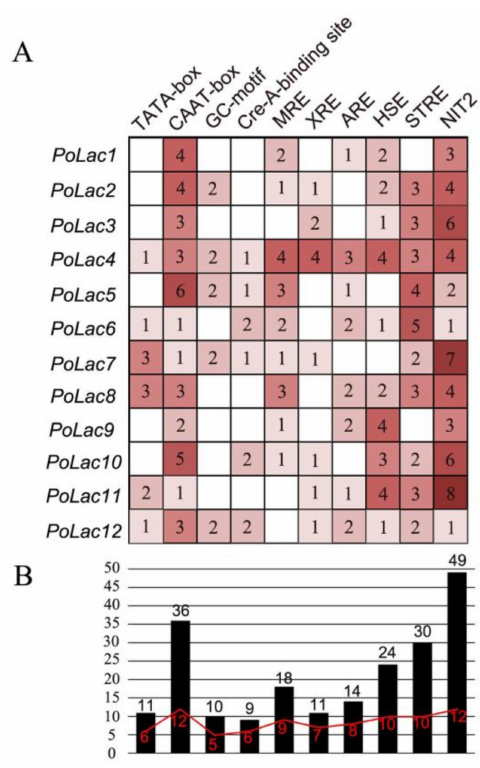
Figure 3. The number and the kind of cis-acting elements in the promoter regions of PoLac s. ( A ) putative cis-acting regulatory elements in the PoLac s promoters; ( B ) the number of cis-acting elements in the PoLac s promoter. And the column graph represents the total number of various cis-elements in the promoters of the PoLac genes, and the fold line indicates the number of genes containing the corresponding cis-elements in promoter